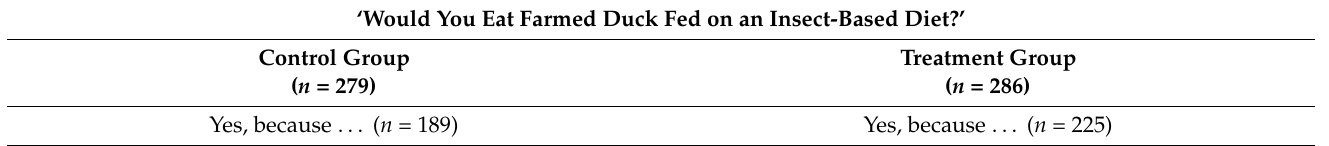
Table A2. Examples of respondent comments based on the different responses and